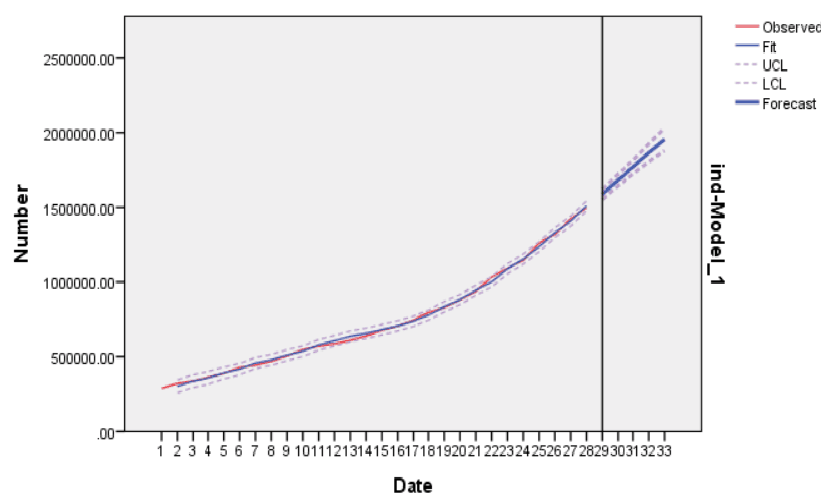
Figure 10. Degree of fitting of the ARIMA model. Table 3. The model statistics for ARIMA.